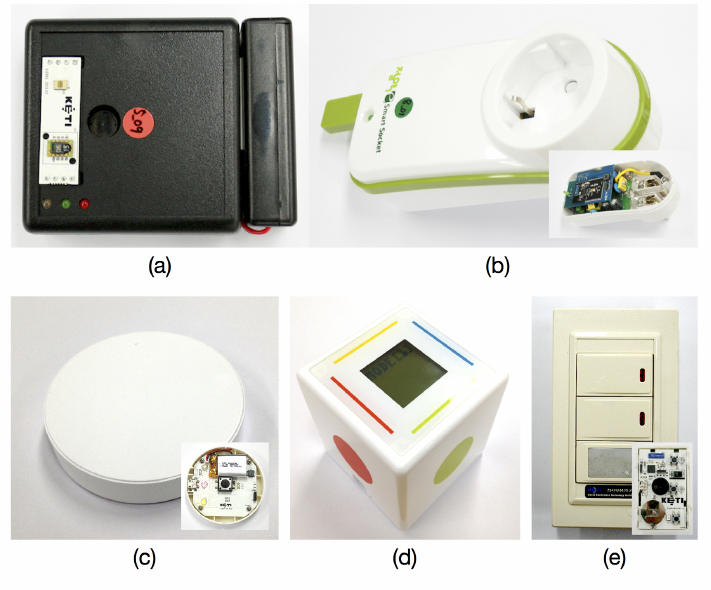
Figure 2. Prototype IoT devices: ( a ) multi-functional sensor for measuring temperature, humidity, illumination, and occupancy; ( b ) smart plug; ( c ) wireless switch; ( d ) smart dice; and ( e ) wall light